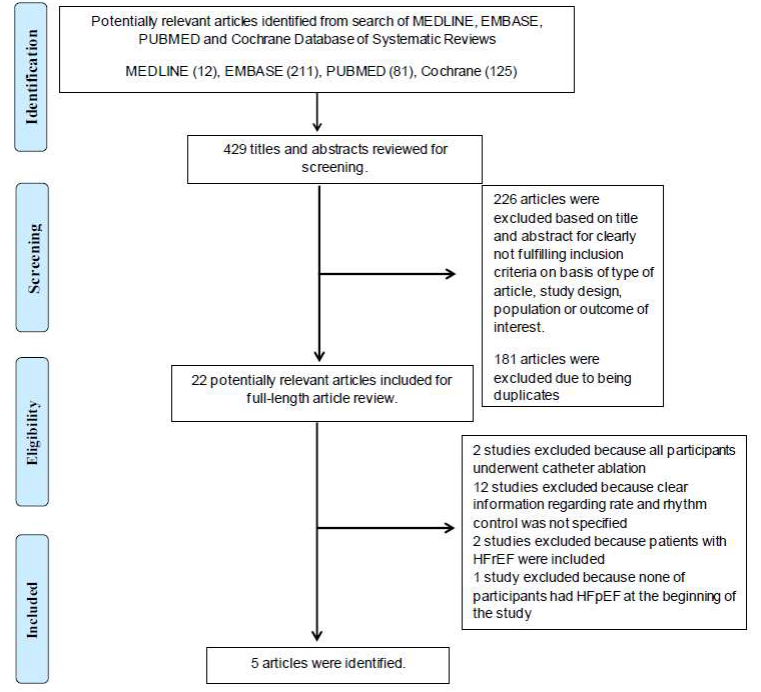
Figure 1. The literature retrieval, review, and selection processes.